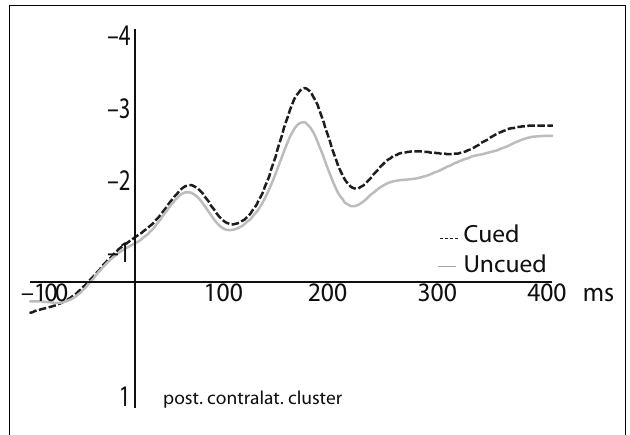
FIGURE 3 | Grand averaged ERPs to probes in the cued (dashed) and uncued (gray) conditions, averaged over the four probe locations.